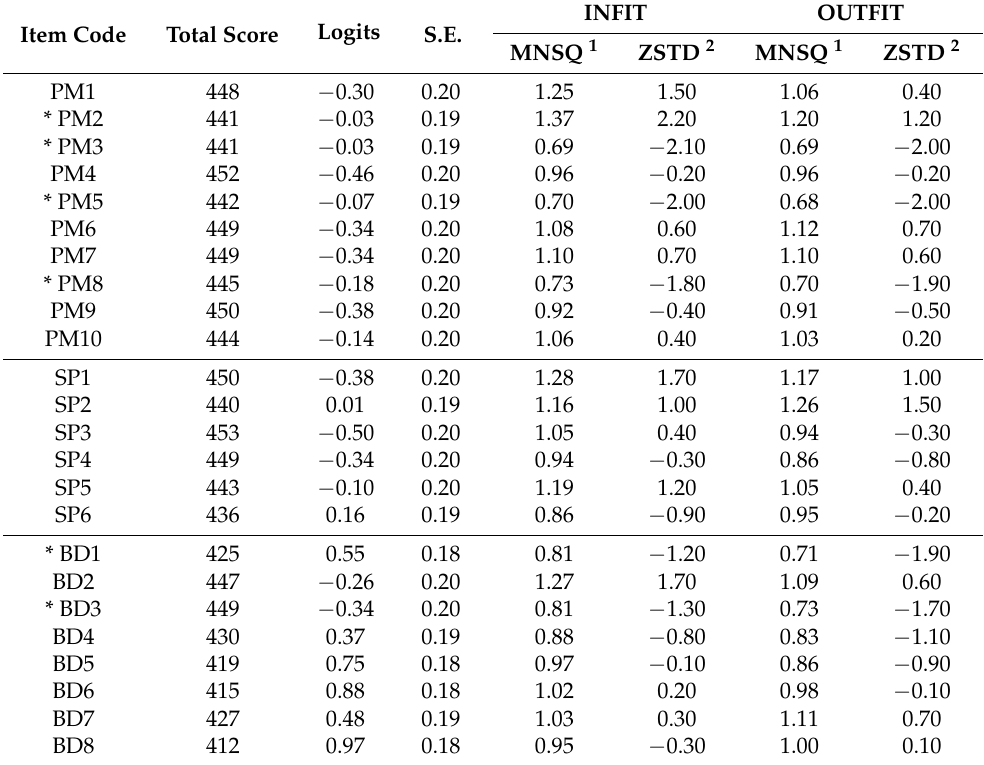
Table 2. Item fit for self-efficacy